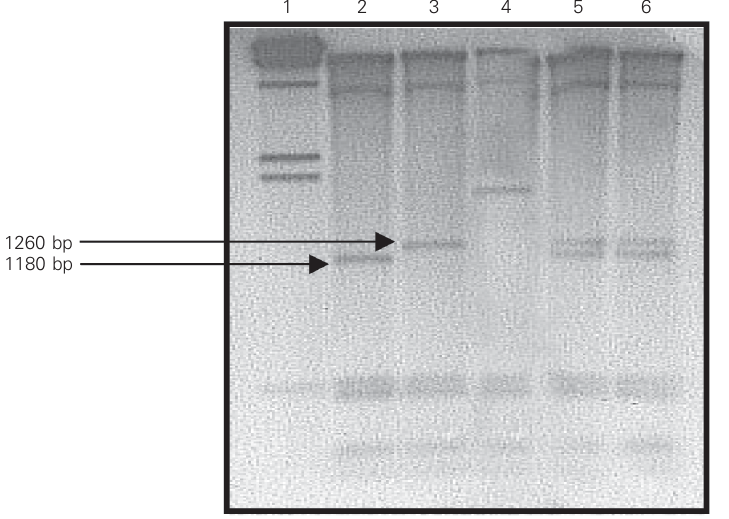
Figure 2. Restriction site heteroplasmy in Brycon opalinus mtDNA. Restriction fragment patterns obtained by Southern blotting from Nhe I digestion. Lane 1 is the λ Hin dIII DNA marker. Lanes 2 , 3 and 4 are the different fragment pattern of Nhe I digestion. Individuals in lanes 5 and 6 are heteroplasmic for Nhe I showing two classes (2 and 3) in the same